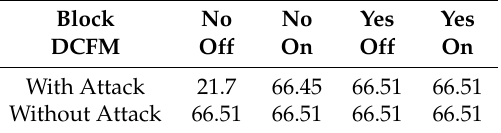
Table 3. Percentages of message Received with DCFM On and Off Before and After Creating Block.